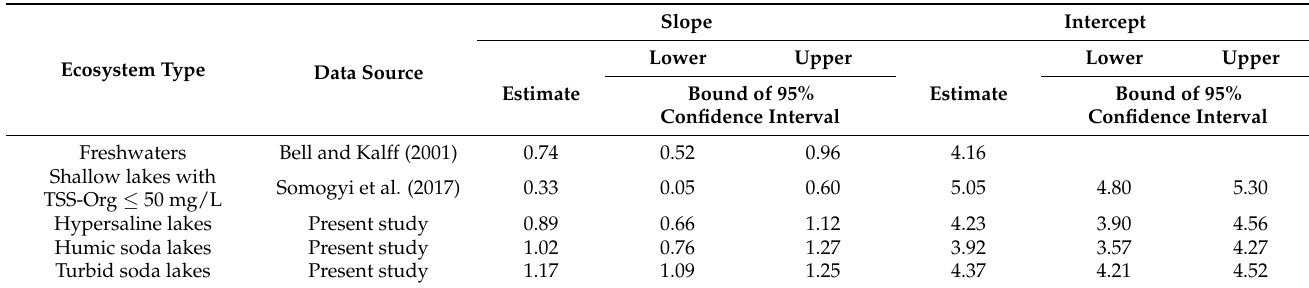
Table 2. Parameters of the lines fitted to the log 10 [APP abundance (cells/mL)] vs. log 10 [chlorophyll a concentration ( µ g/L)] relationships. The data used for the relationships of soda and hypersaline waters are from the publications in Table S2 expanded with unpublished